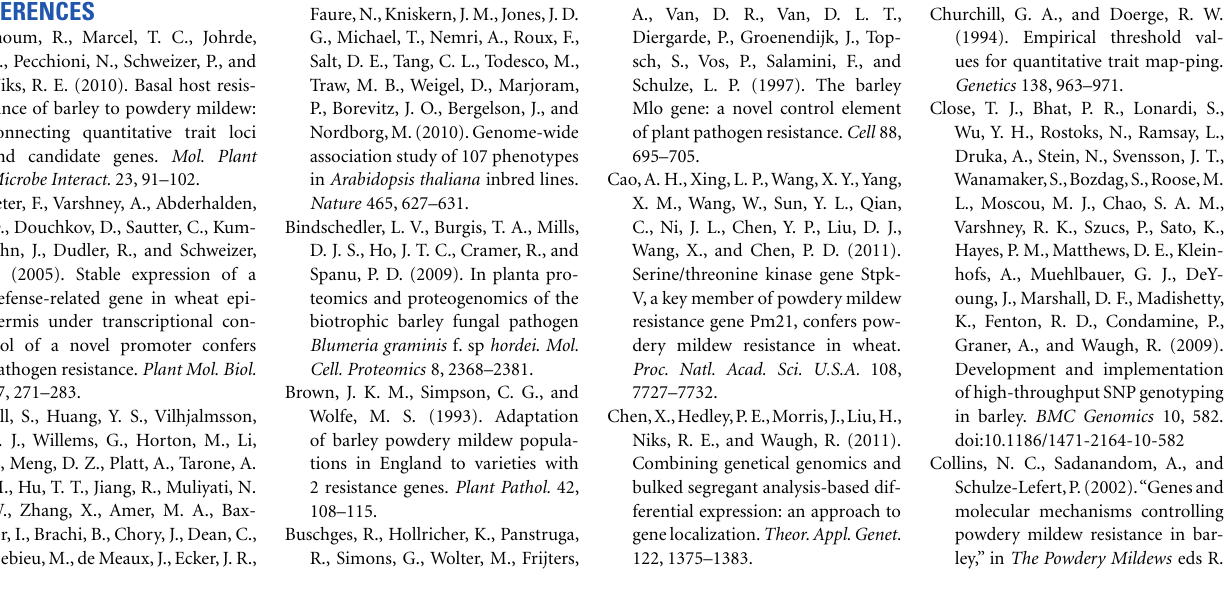
Table S1 | Summary of association of allelic variants of polymorphic CGs with the Bgh -interaction phenotype and with row number. Table S2 | Kinship (K) matrix of the customized barley collection based on 42 SSR markers. Software SPAGeDi1.2 (Hardy andVekemans, 2002) was used to calculate kinship. Table S3 | Structure (Q) matrix of the customized barley collection based on 42 SSR markers. Software STRUCTURE (Pritchard et al., 2000) was used to calculate population structure. Table S4 | Correlation between row number of barley genotypes and resistance to Bgh . Table S5 | Normalized and log(2) transformed signal intensity data (single-channel analysis) of selected transcripts corresponding to genes associated with resistance to Bgh . RNA was extracted from epidermal peels of barley after inoculation with either Bgh or the non-host pathogen B. graminis f. sp. tritici (Bgt). Table S6 | Primers used for the re-sequencing of CGs. Please note that the lower case letters correspond to adapters containingT3 orT7 primer binding sites used for Sanger sequencing of amplified DNA fragments on an ABI 3730